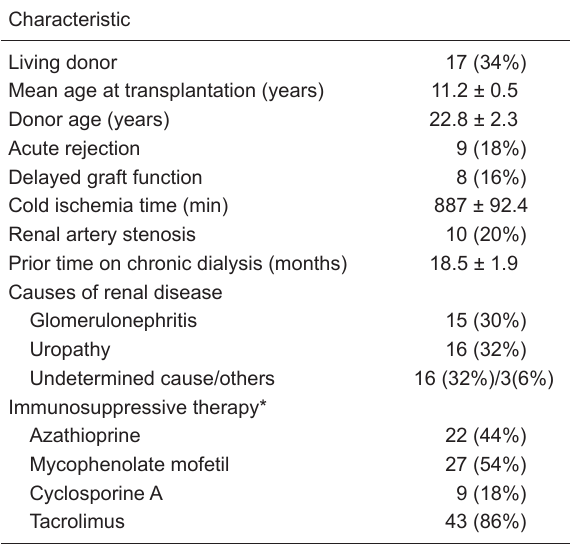
Table 1. Clinical characteristics of the 50 pediatric renal trans- plant